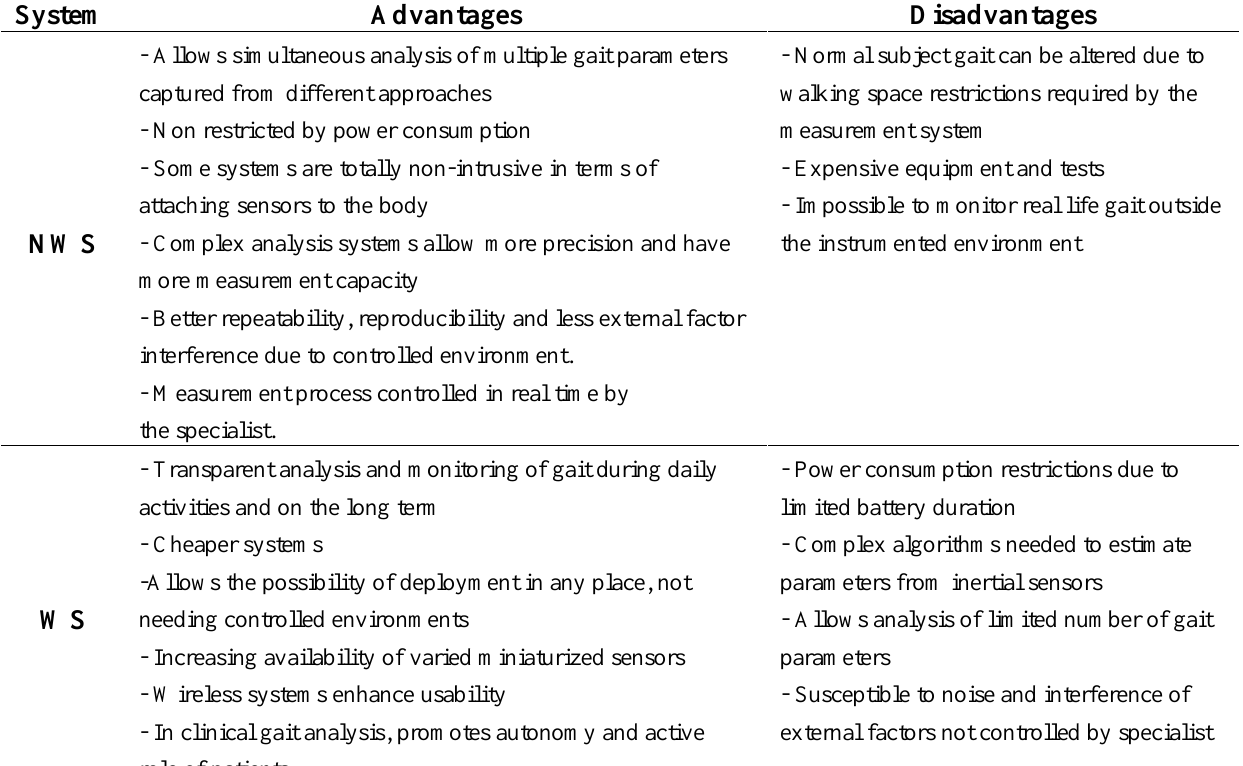
Table 3. Comparison between NWS and WS